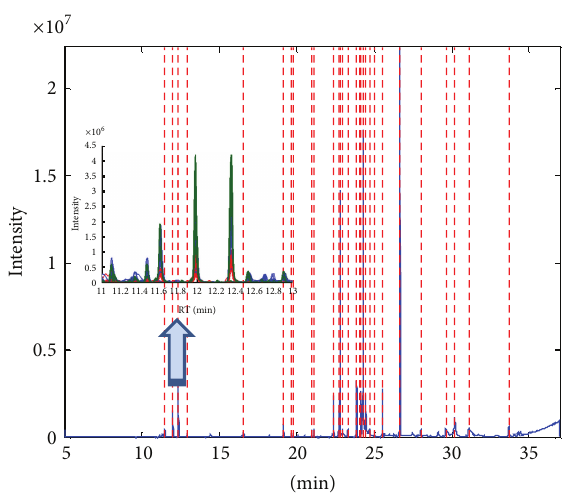
Figure 5: Peaks identified in a GCMS chromatogram with the inset exhibit several commonly present dienaldehyde peaks matched across the chromatograms with blue, red, and green lines indicating unheated samples, samples heated at 100 ∘ C and 150 ∘ C,